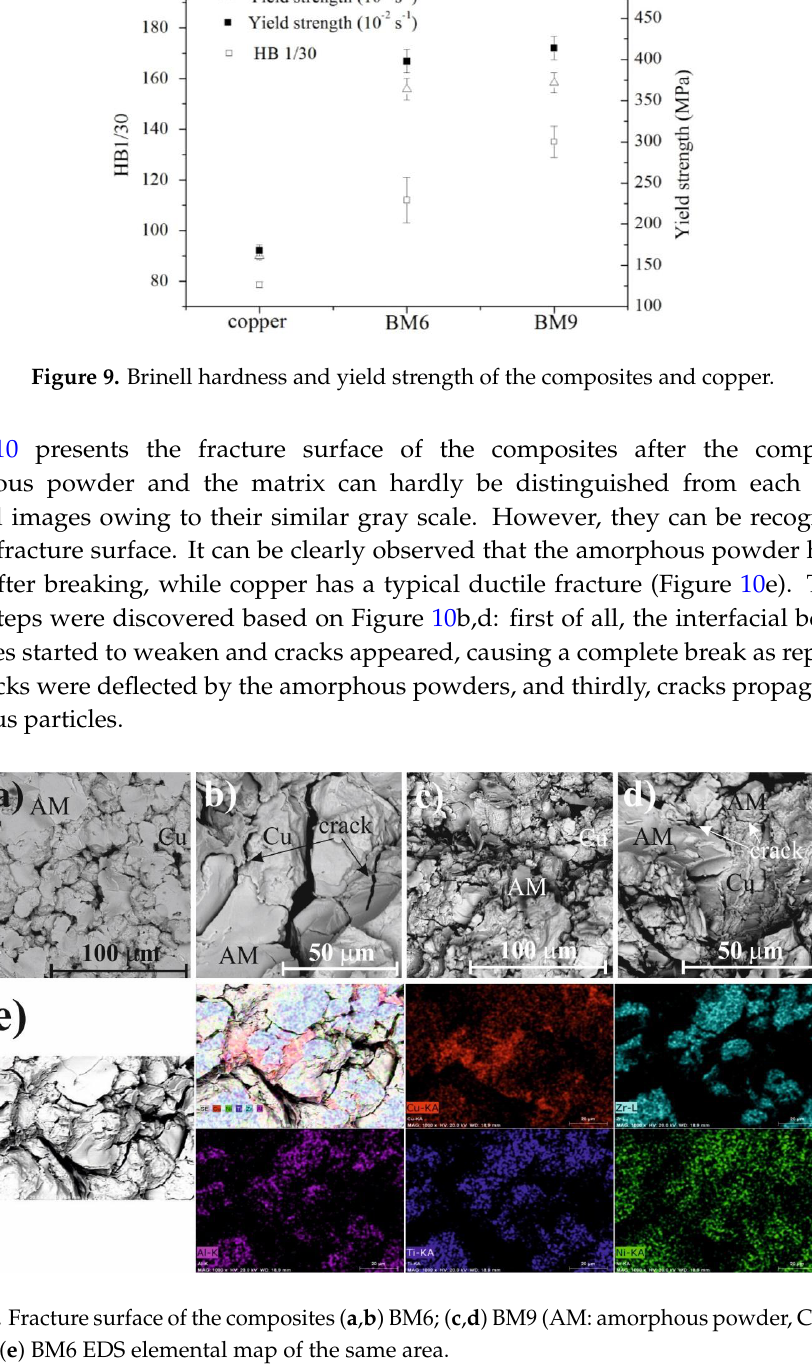
Figure 10. Fracture surface of the composites ( a , b ) BM6; ( c , d ) BM9 (AM: amorphous powder, Cu: copper powder); ( e ) BM6 EDS elemental map of the same area. powder); ( e ) BM6 EDS elemental map of the same